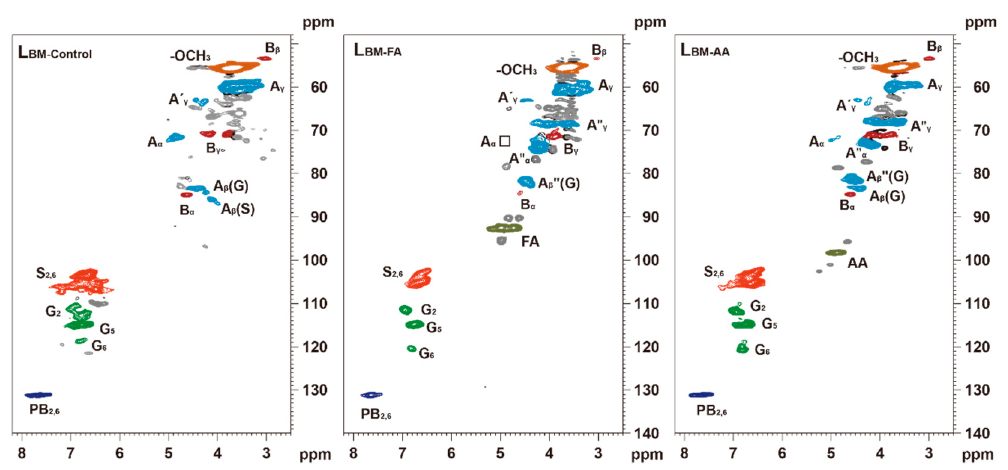
Figure 2. 2D-HSQC spectra of the lignin obtained from ball-milled poplar wood. L BM-Control represents the lignin extracted from an acid solvent without the addition of aldehyde; L BM-FA represents the lignin extracted with the presence of FA; L BM-AA represents the lignin extracted with the presence of AA. The C β –H β correlations were observed at δ C / δ H 83.5/4.41 and 86.0/4.12 for β - O -4 substructures linked